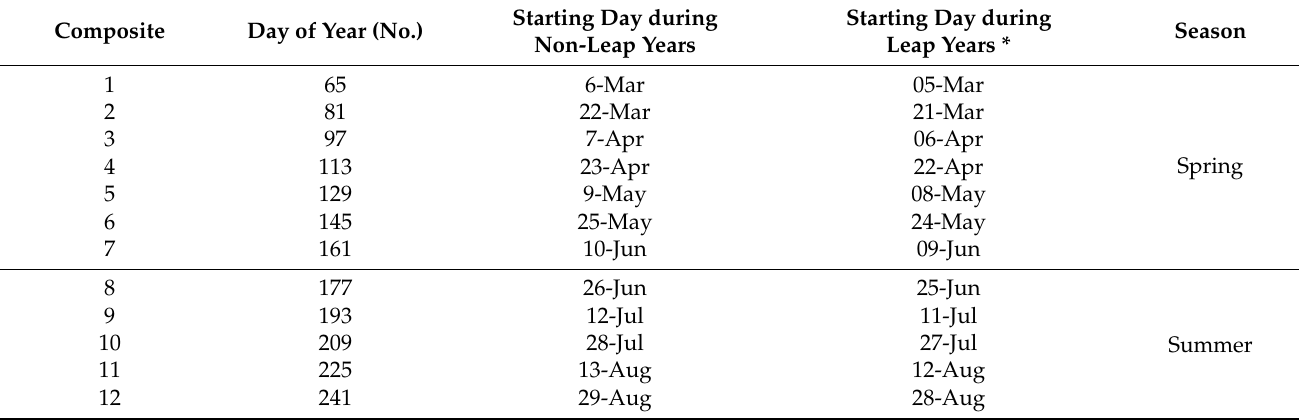
Table 2. Composite periods of MOD13 used in the study [61].